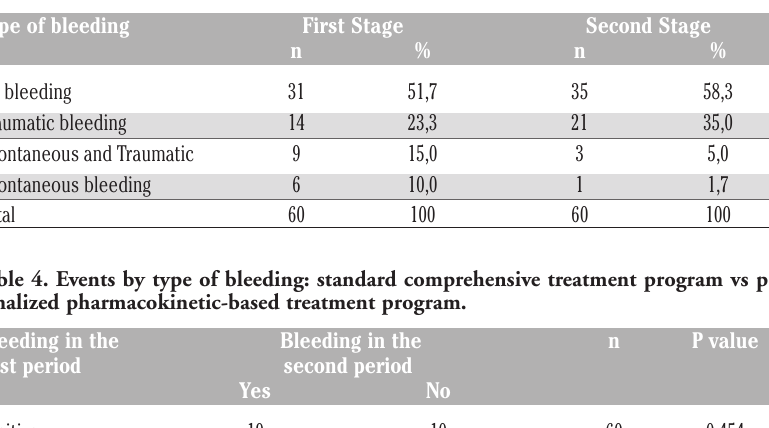
Table 3. Types of bleeding: standard comprehensive treatment program (first stage) vs personalized pharmacokinetic-based treatment program (second